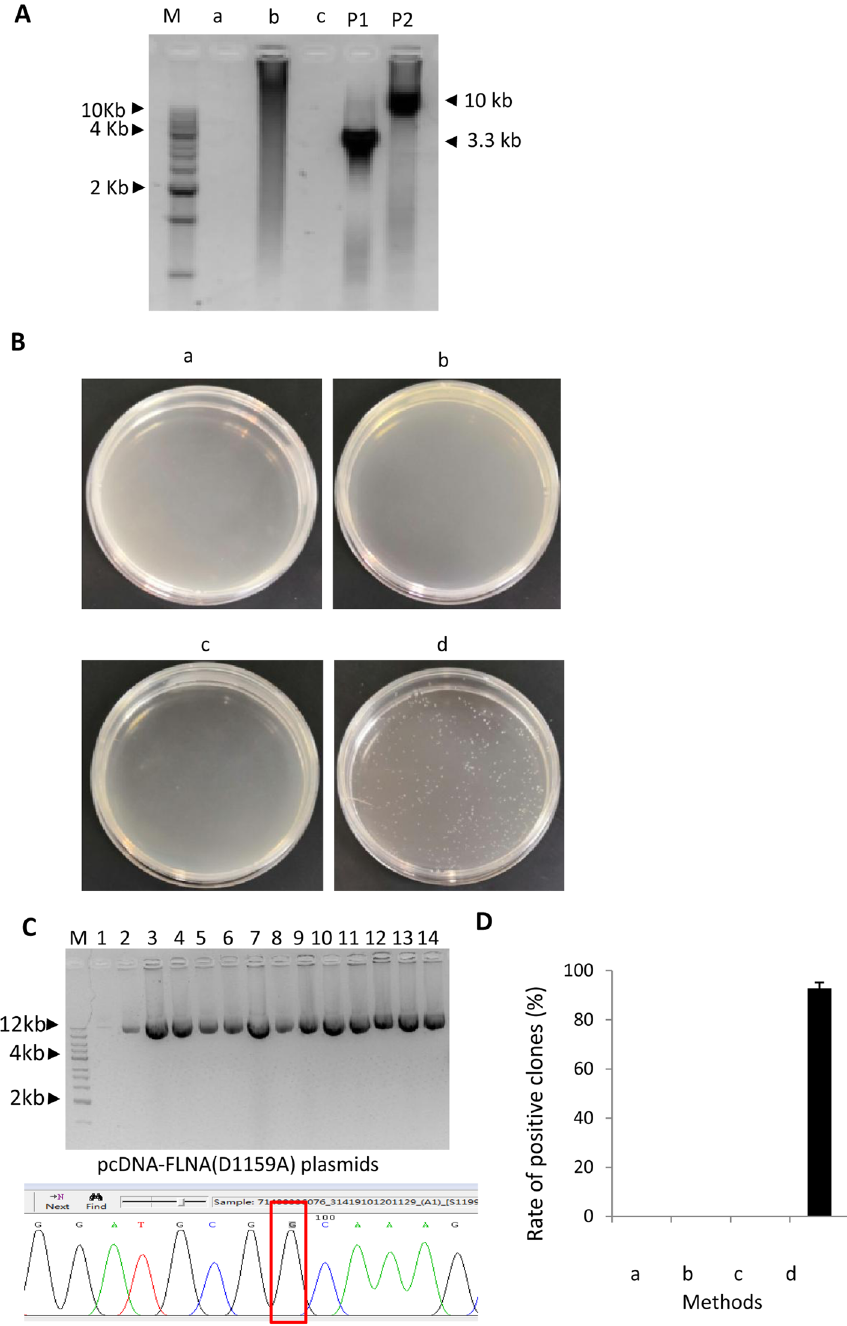
Figure 7. The SMLP method has an advantage over the conventional methods in the mutagenesis of large plasmids. ( A ) Detection of the PCR products from different methods for site-directed mutagenesis by agarose gel electrophoresis. a, PCR with a double-strand DNA fragment; b, PCR with a pair of partially complementary primers; c, PCR with a pair of inverse primers; P1, the small DNA fragments from PCR with the primer pair of pcDNAFP and D1159ARP; P2, the large DNA fragments from PCR with the primer pair of pcDNARP and D1159AFP. ( B ) Comparison of the transformation efficiency for the different methods for site-directed mutagenesis. The samples used for transformation were generated according to their respective methods as indicated. a, the transformation result from the method based on the PCR with a pair of complementary primers; b, the transformation result from the method based on the PCR with a pair of partially complementary primers; c, the transformation result from the method based on the PCR with a pair of inverse primers; d, the result from the SMLP method. ( C ) Analysis of the pcDNA-FLNA plasmid derived from site-directed mutagenesis by the SMLP method using agarose gel electrophoresis and DNA sequencing. Lane 1 to 13 in the image represents the plasmids from different colonies generated by the SMLP method, whereas lane 14 represents the pcDNA-FLNA original plasmid (Top panel). The mutated base in the sequencing map (bottom panel) was enclosed with the red rectangle lines as in Fig. 6E. ( D ) Comparison of the rate of positive clones from different methods for site-directed mutagenesis. a, b, c, and d in the graph represent the results from their respective methods as described in ( B ). The rate of the positive clones was obtained by calculating the percentage for the number of the mutants in the number of colonies